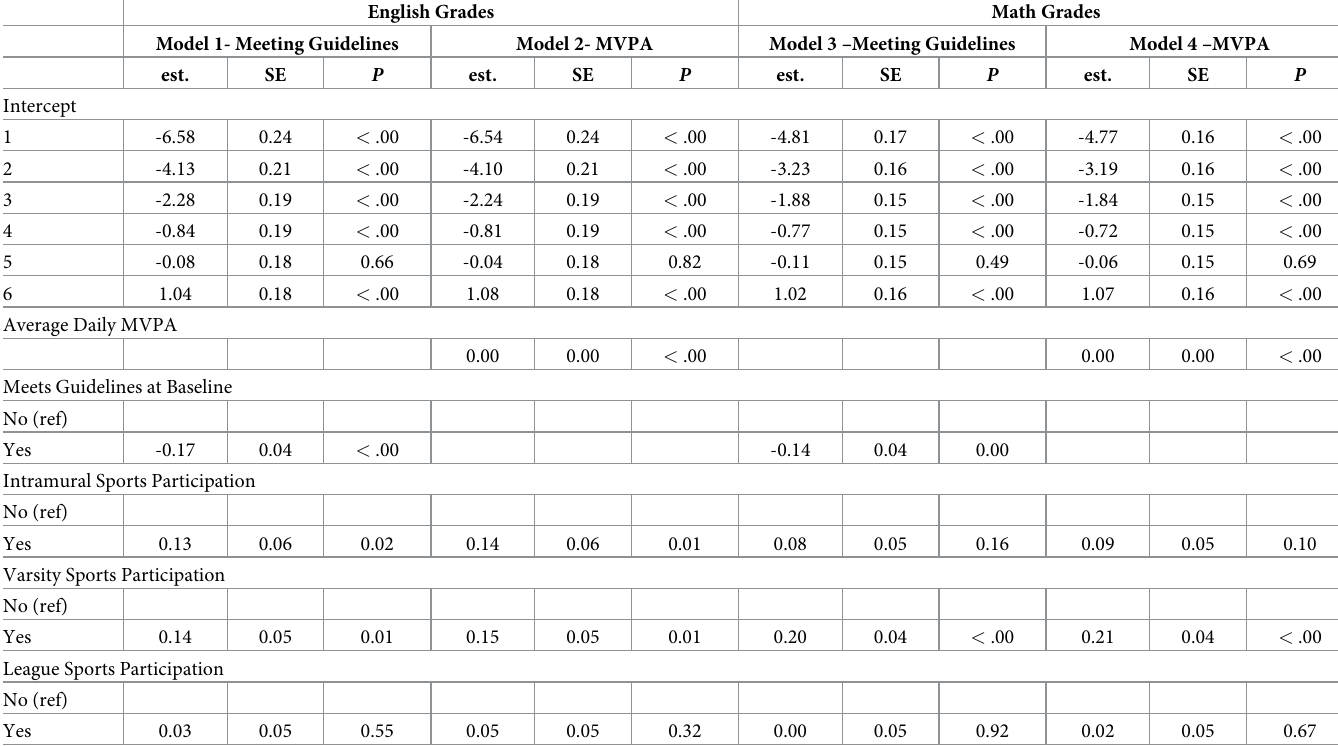
Table 5. Categorical analysis of the physical activity predictors and academic outcomes: Ontario and Alberta, Canada (2013-2014/2015-2016). English